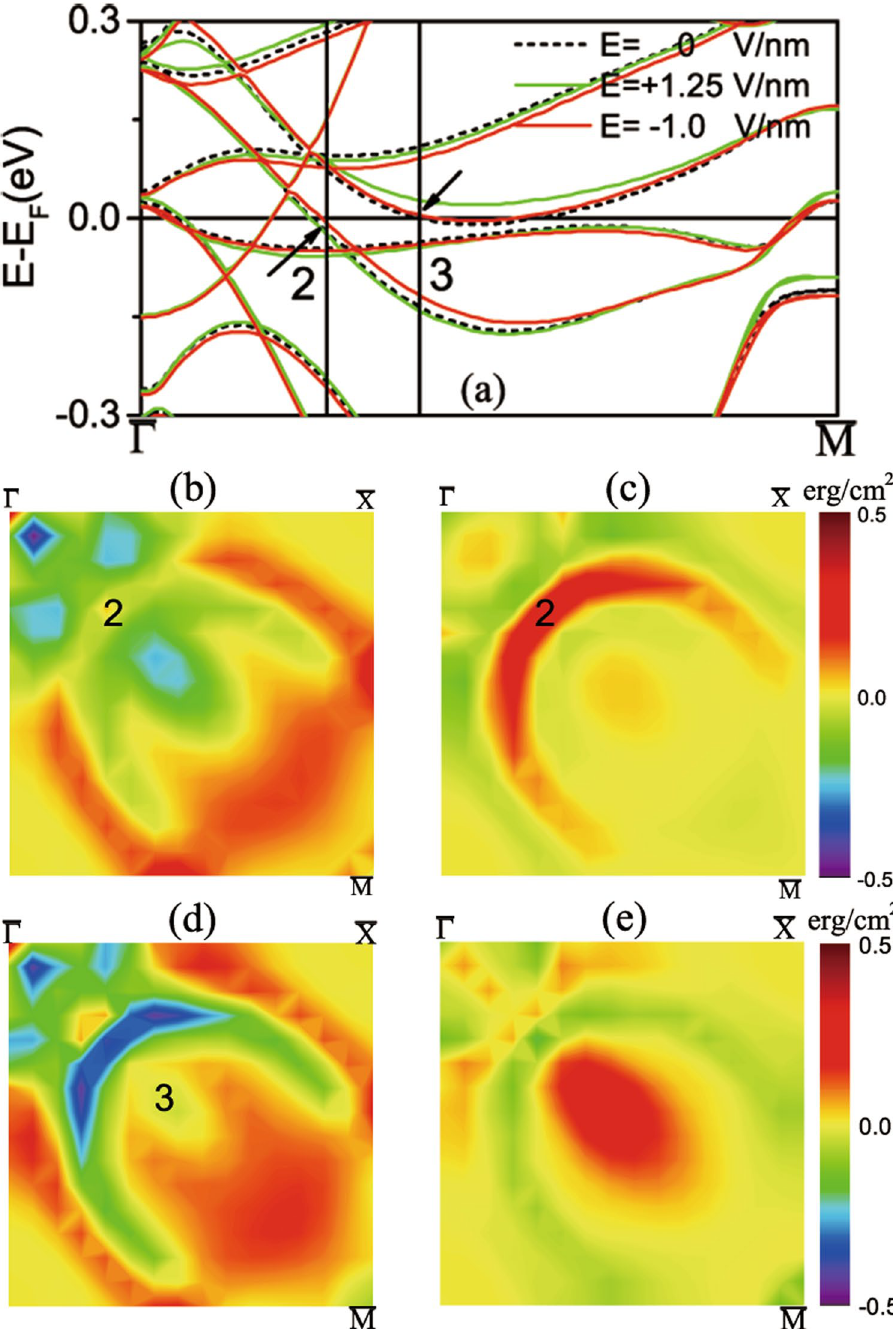
Figure 4. G-AFM/Fe-terminated FeRh/MgO bilayer under − 0.57% strain: ( a ) Shift of minority-spin bands along the Γ M direction under zero (black curves), + 1.25 V/nm (green curves) and − 1 V/nm (red curves), respectively. ( b ) k -resolved MA in quarter of 2D BZ under − 1 V/nm. ( c ) Δ MA( k ) = MA( k , E) -MA( k , E = 0), under − 1 V/nm. ( d ) k -resolved MA in quarter of 2D BZ under + 1.25 V/nm. ( e ) Δ MA( k ) = MA( k , E)-MA( k , E = 0), (in erg/cm 2 ) under + 1.25